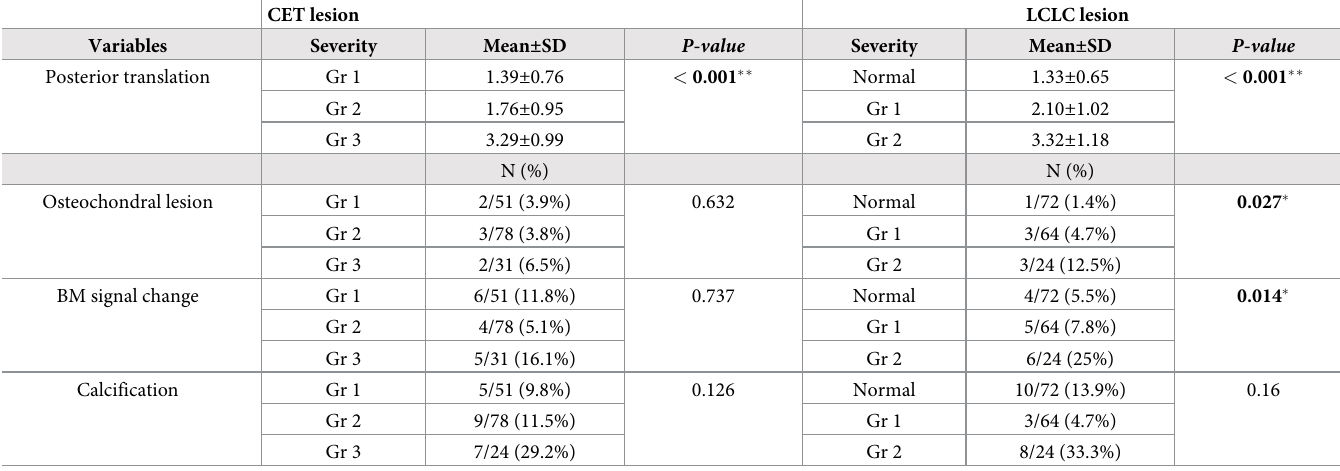
Table 3. Trend analysis for the severity of CET and LCLC lesions.